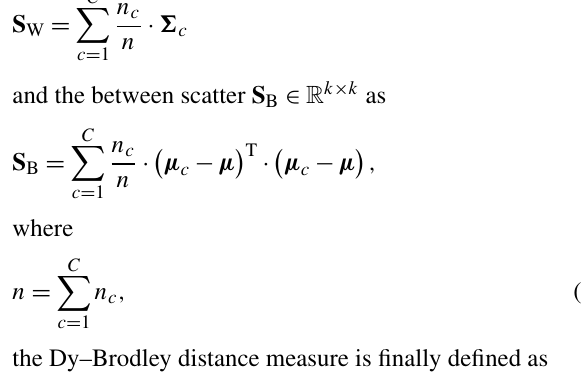
Figure 7. Normal probability plots of the feature interquartile range, 3000rpm data, PCB sensor, and states Healthy2 and